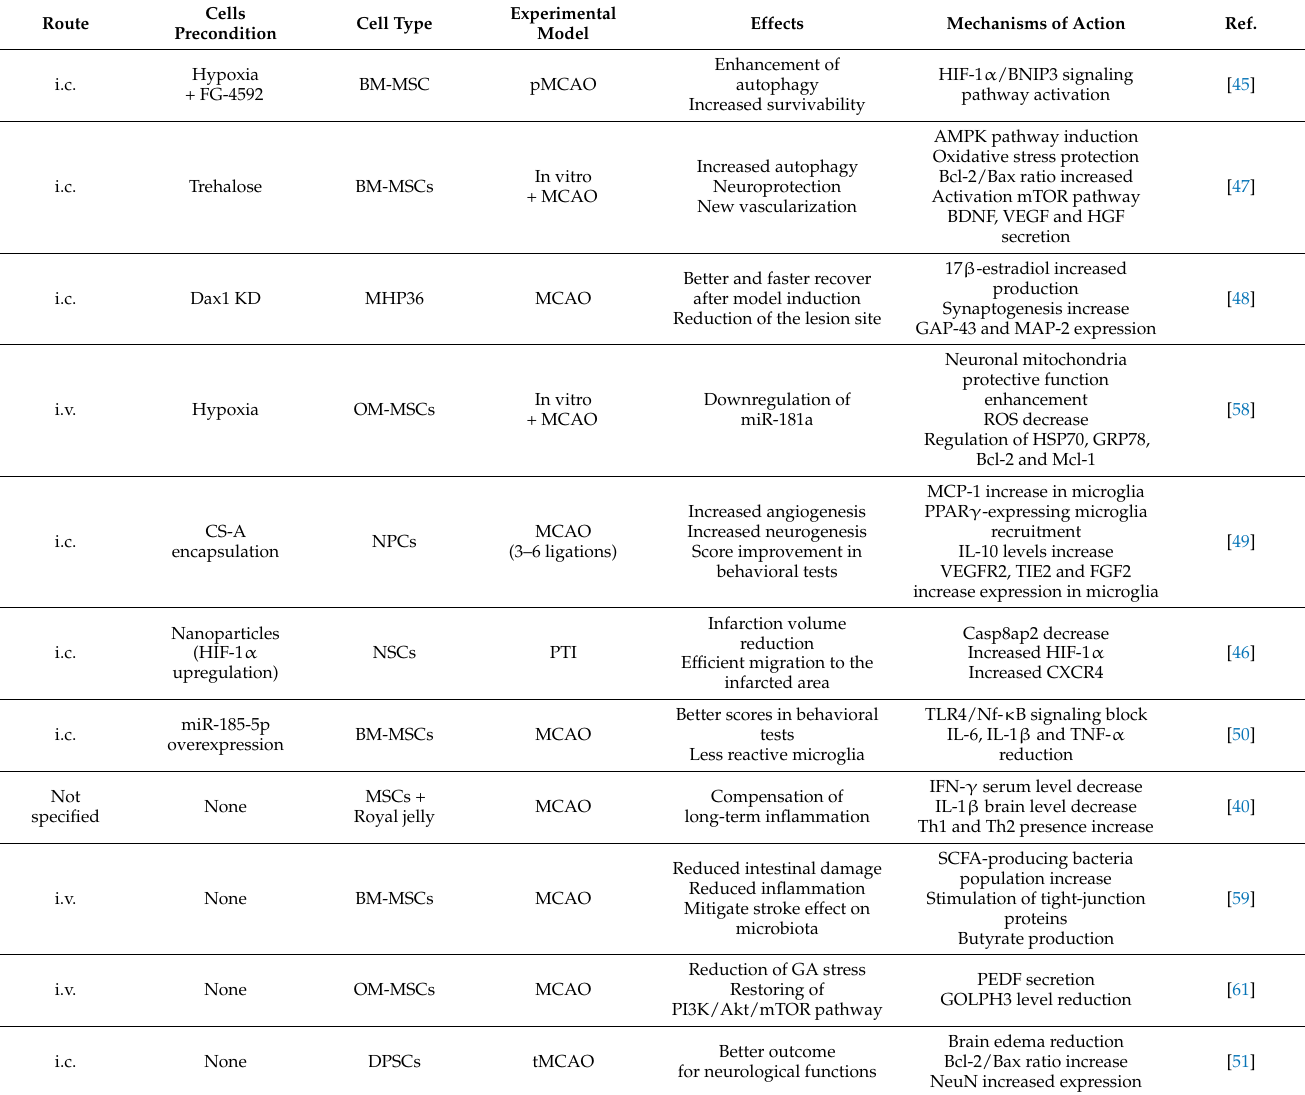
Table 2. Classical route of administration and preconditioning strategies in different animal models of